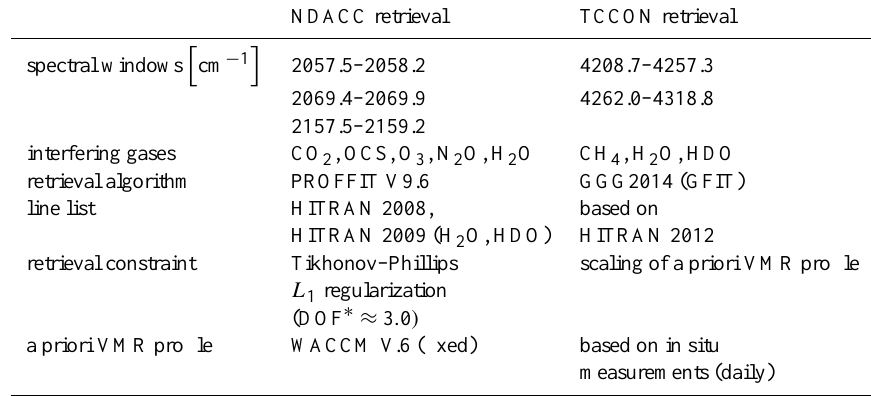
Table 1. Retrieval strategies for CO for spectra recorded in the MIR and NIR spectral region.